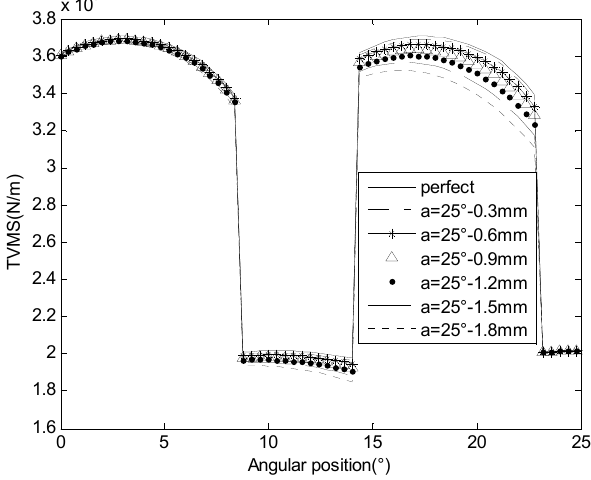
ff ness of the 20 ◦ pressure angle. Figure 8. Meshing stiffness of the 20° pressure angle. Figure 8. Meshing sti Figure 8. Meshing stiffness of the 20° pressure angle.